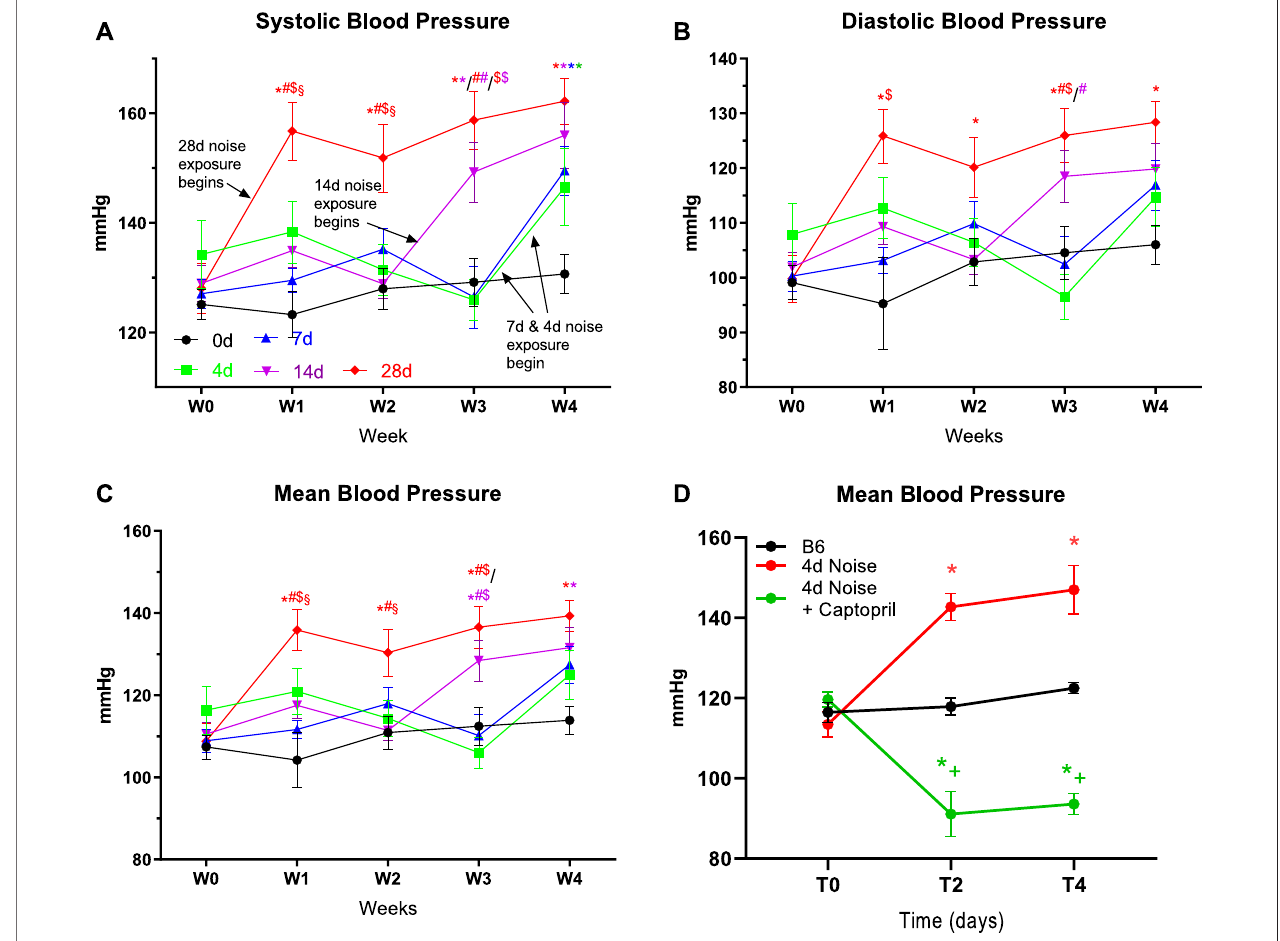
FIGURE 1 | Effects of long-term noise on blood pressure. Blood pressure was evaluated weekly over the course of treatment. (A, B, C) Blood pressure increased signi fi cantly in every noise-exposed group by the time point following their initial noise exposure in systolic, diastolic, and mean pressures. (D) Therapy with the ACE inhibitor captopril prevented blood pressure increase by noise at 2 or 4 days of exposure. Data are mean ± SEM. Statistical analysis with two-way ANOVA with Tukey ’ s multiplecomparison test.Pointsrepresentthemeanofthegroup,averagingof10measurementcyclesperanimal,n (cid:1) 6 – 9. (A-C) p < 0.05:*vsrespectiveto0d,# to 4d, $ to 7d, § to 14d and + to 28d; (D) + to noise exposed group. W0-W4 de fi nes the week of noise